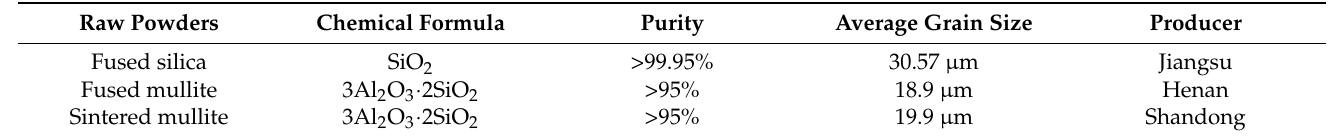
Table 1. Information about raw materials.